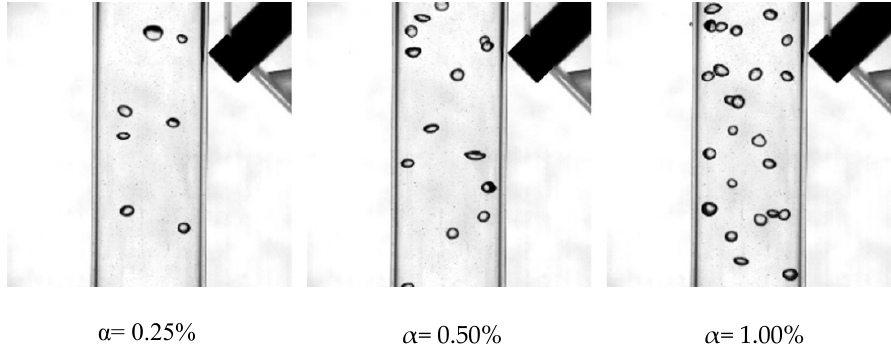
Figure 18. The image of bubble distribution in a different void fraction.